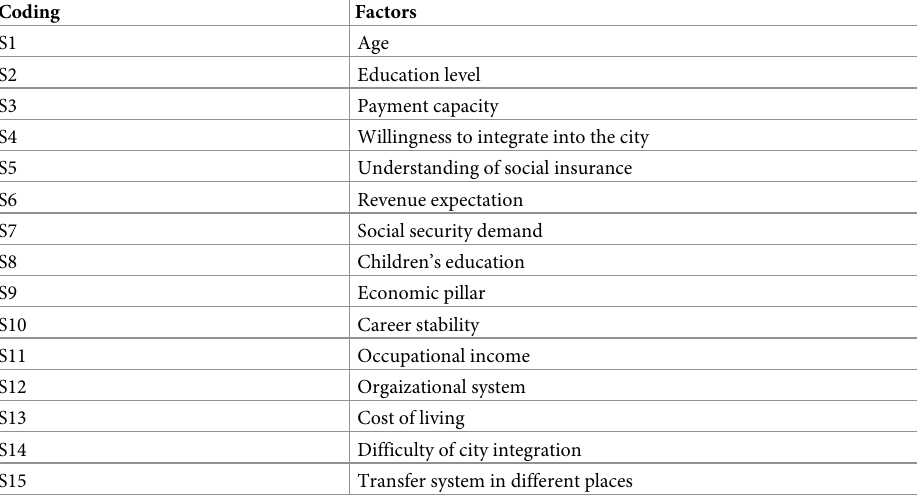
Table 1. 15 influence